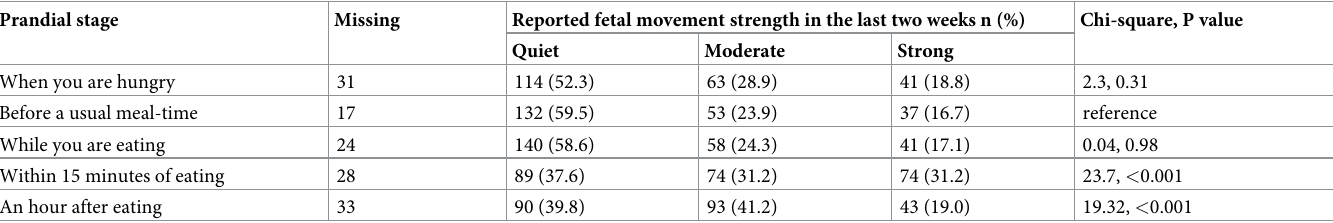
Table 4. Perceived strength of fetal movements in relation to meals (N = 239). Prandial